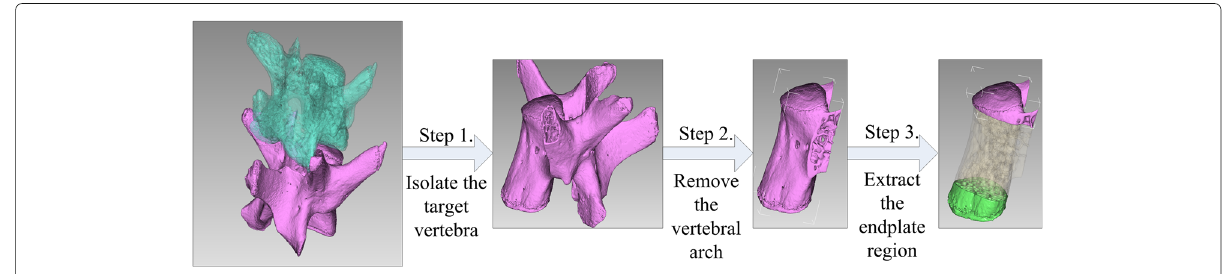
Fig. 3 The workflow of the proposed pre-processing